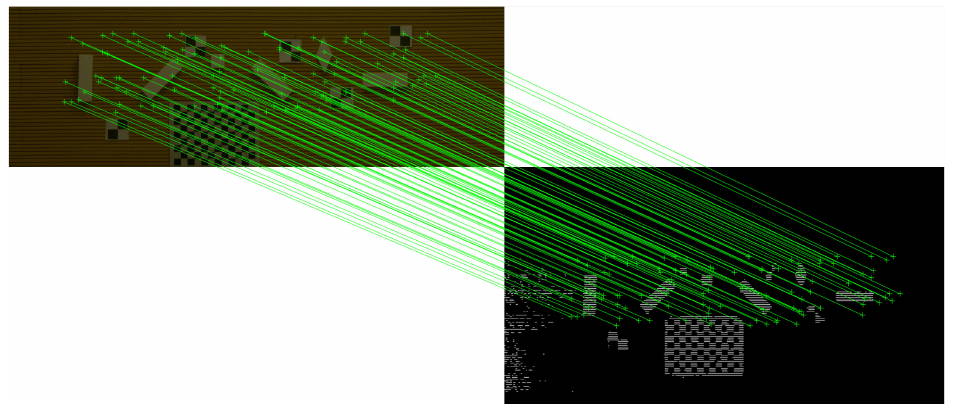
Figure 13. Distribution of the point pairs for the accuracy verification in the camera image and LiDAR image.